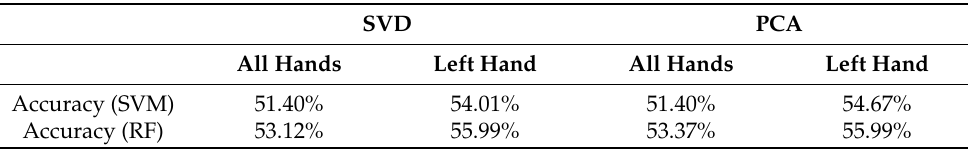
Table 4. The composite activity recognition using a set of optimal features derived from the subspace pooling technique. The features are classified with hold-out cross-validation. The average recognition accuracy with hold-out cross-validation is also